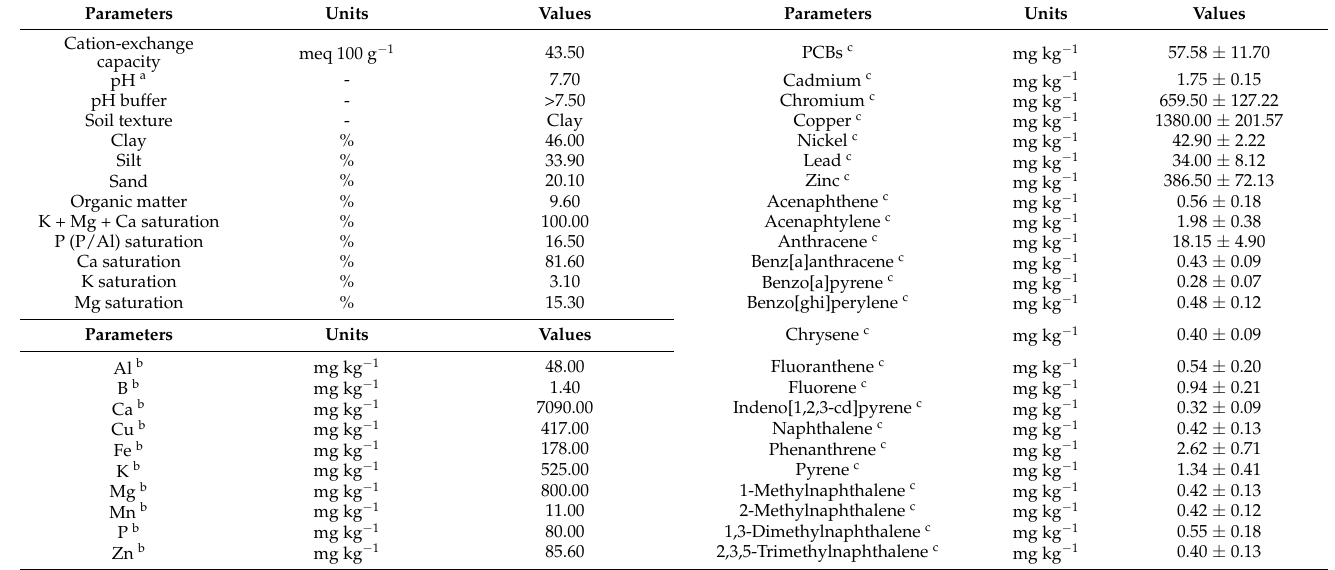
Figure 1. Evolution of the experimental design over time. ( A ) The first experimental phase (phase 1) on what is referred to as the GERLED site in Guidi et al. [6]. The 21 dotted lines inside the willow plantation refer to the rows planted with the cultivar ‘SX61’ (red lines) and with the cultivar ‘SX64’ (grey lines). P1 to P4 refer to the sampling plots in their study [6]; ( B ) the second experimental phase (phase 2) studied by Fortin Faubert et al. [17]. Colored areas refer to the experimental plots supplemented with spent mushroom substrates (SMS) and/or with ramial chipped wood (RCW), or simply left as bare ground (BG). The control sections (Ctrl) were located at the extremity of each block. Although preserved as part of the plantation, the sections in dark grey were not used in the present study (Unused area); ( C ) the present experiment (phase 3). Colored areas refer to the experimental plots where willows were cut (Cut) or left in place (Salix). Adapted from Guidi et al. [6]. Table 1. Soil characteristics of the site in